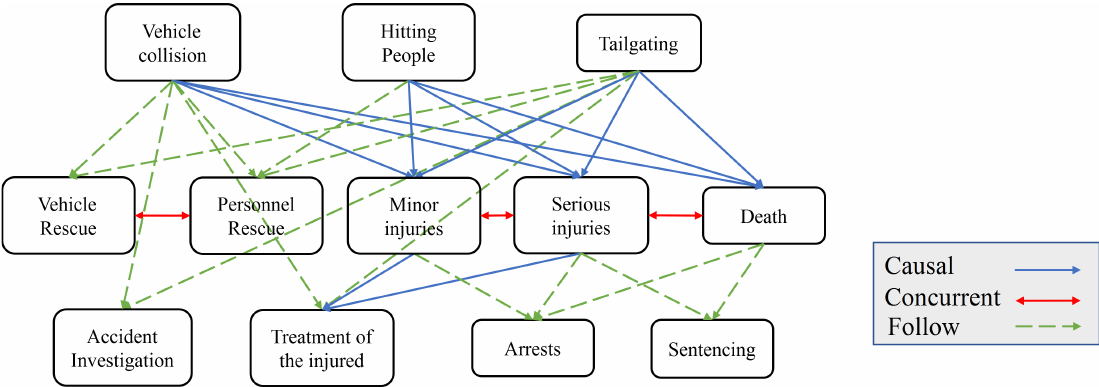
Figure 4. Part of traffic accident scenario